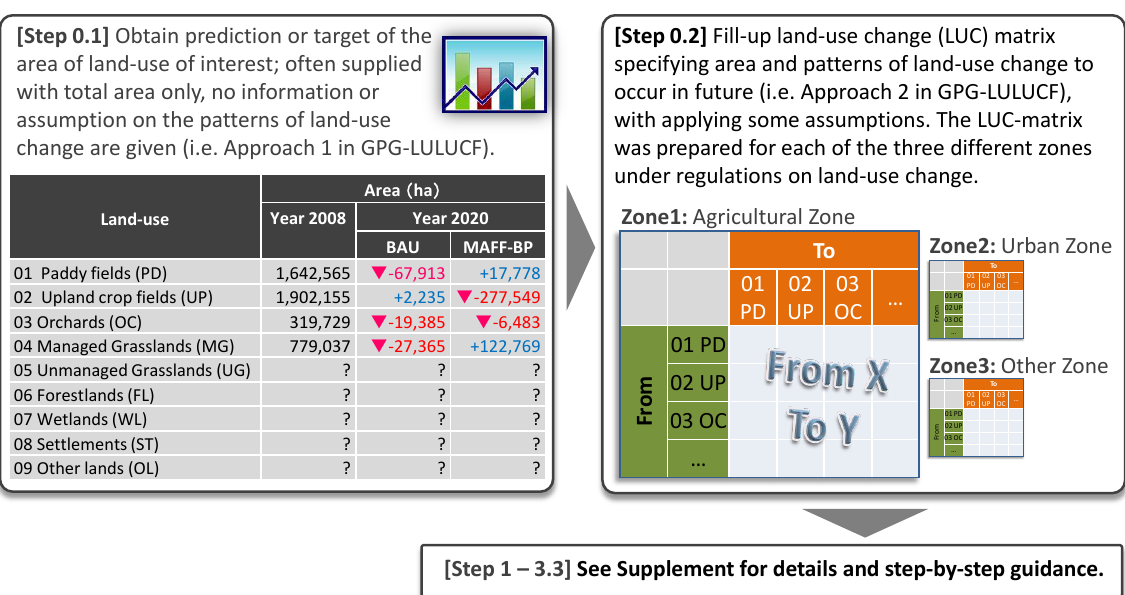
unequal size of land area between base year and commitment period.